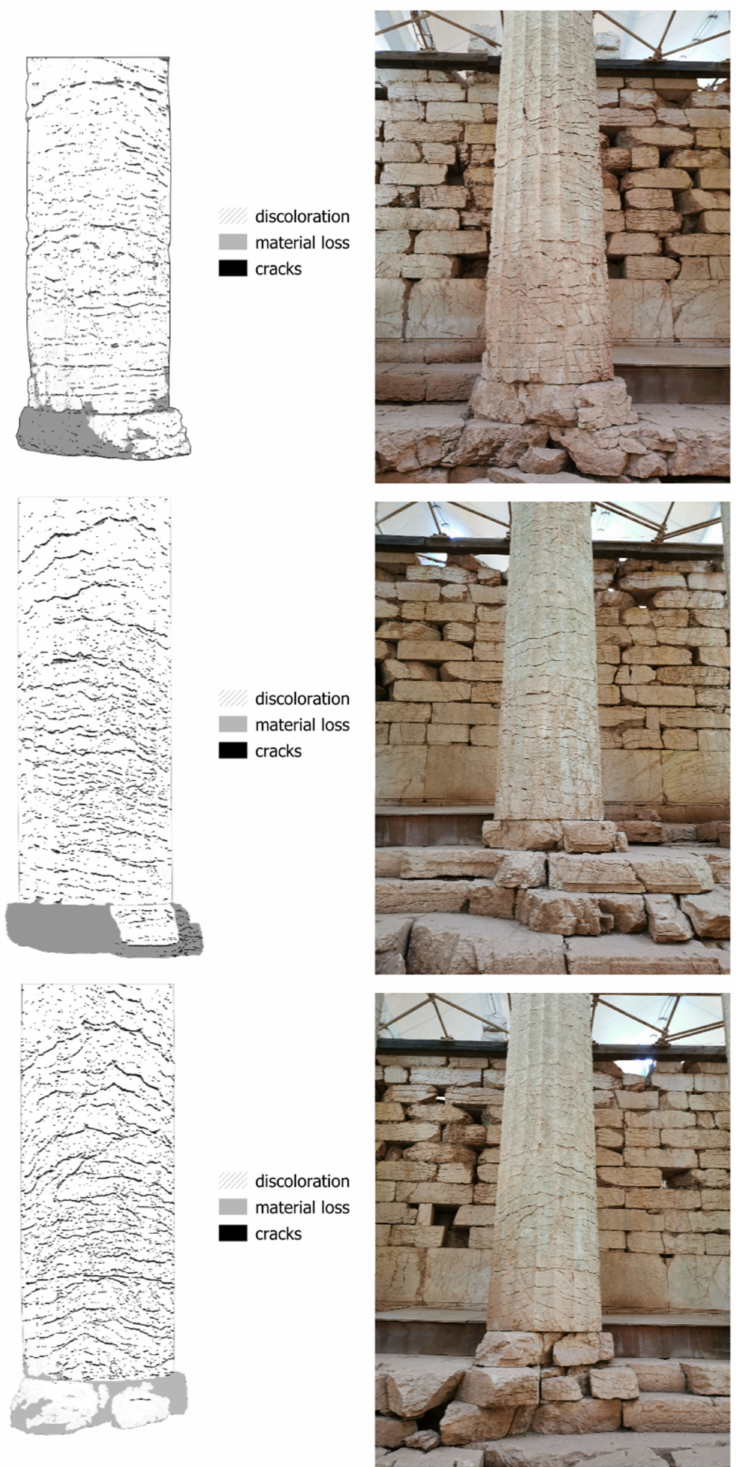
Figure 7. Degradation maps and corresponding images for characteristic areas of columns at the Temple of Apollo